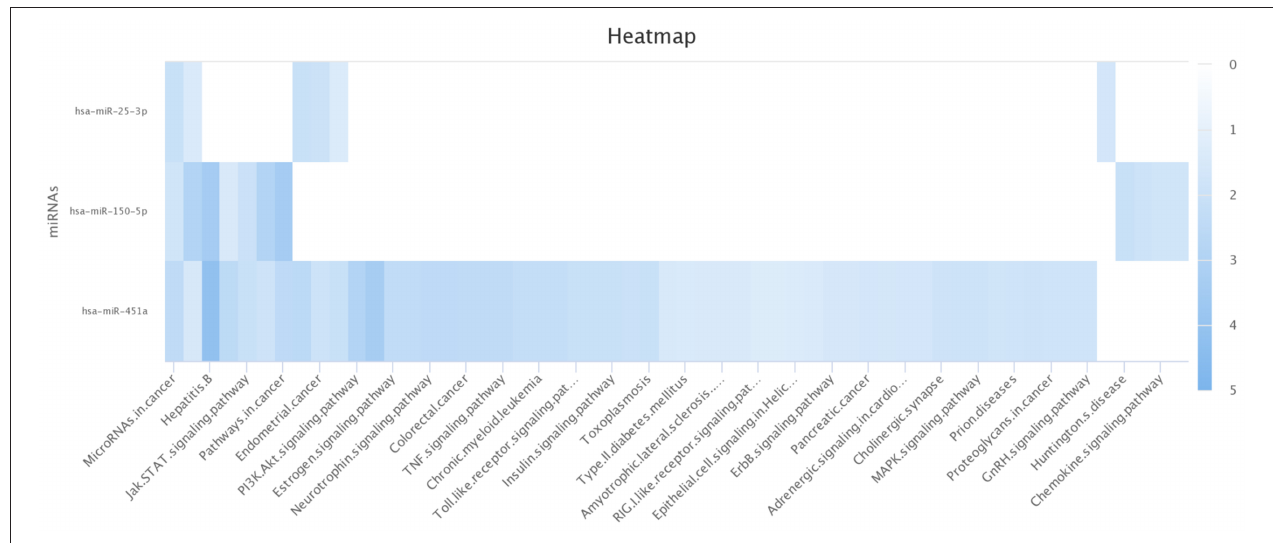
FIGURE 5 | Significantly enriched pathways for the miRNAs. miR-451a is statistically significant for both pathways: PI3K-AKT and MAPK. The other pathways are modulated by the three identified miRNAs (miR-150-3p, mir-25-3p, and mir-451a). This image was generated using the miRPathDB 2.0 tool (46).